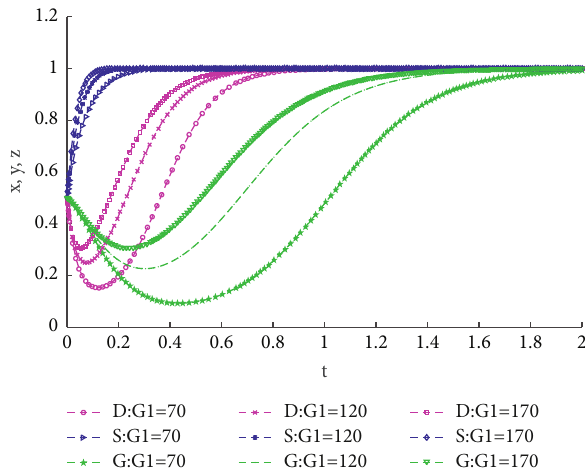
Figure 3: The evolutionary result of the platform’s rewards for service providers.